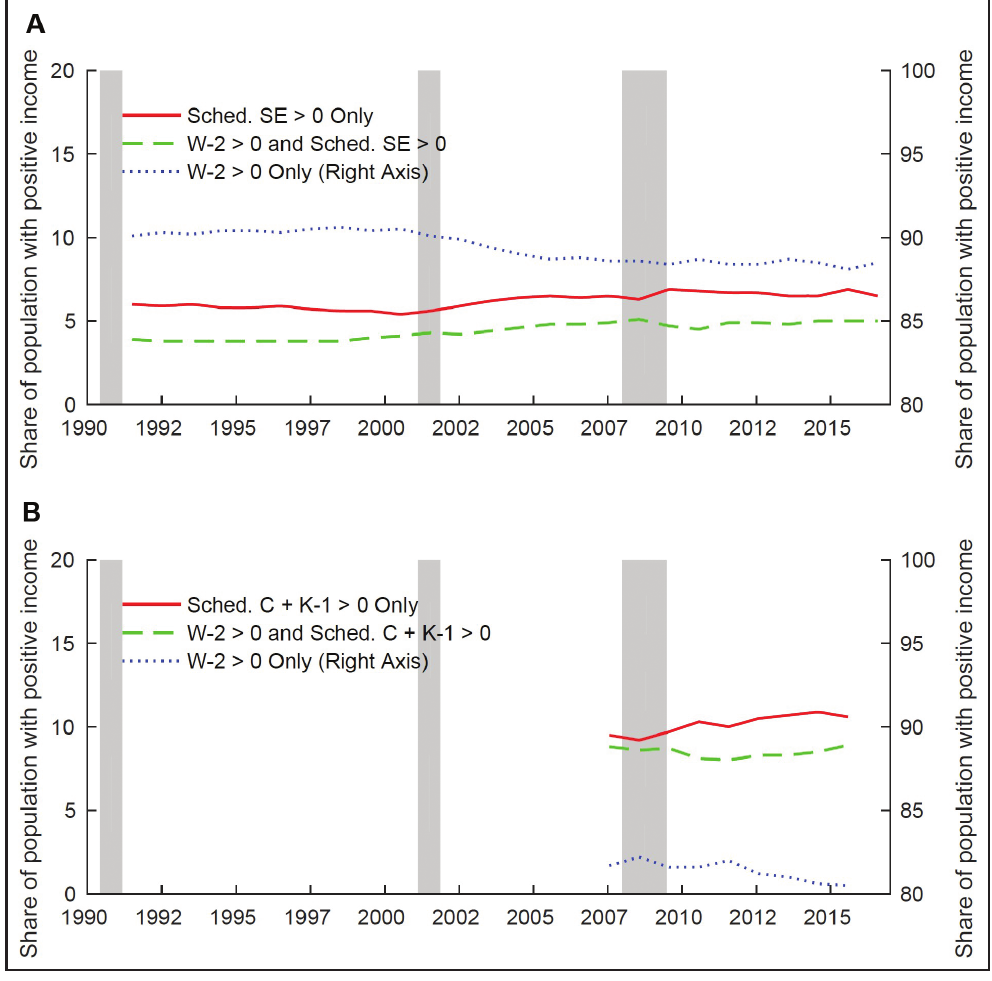
Figure 1 Shares of the population with income in a calendar year, by income